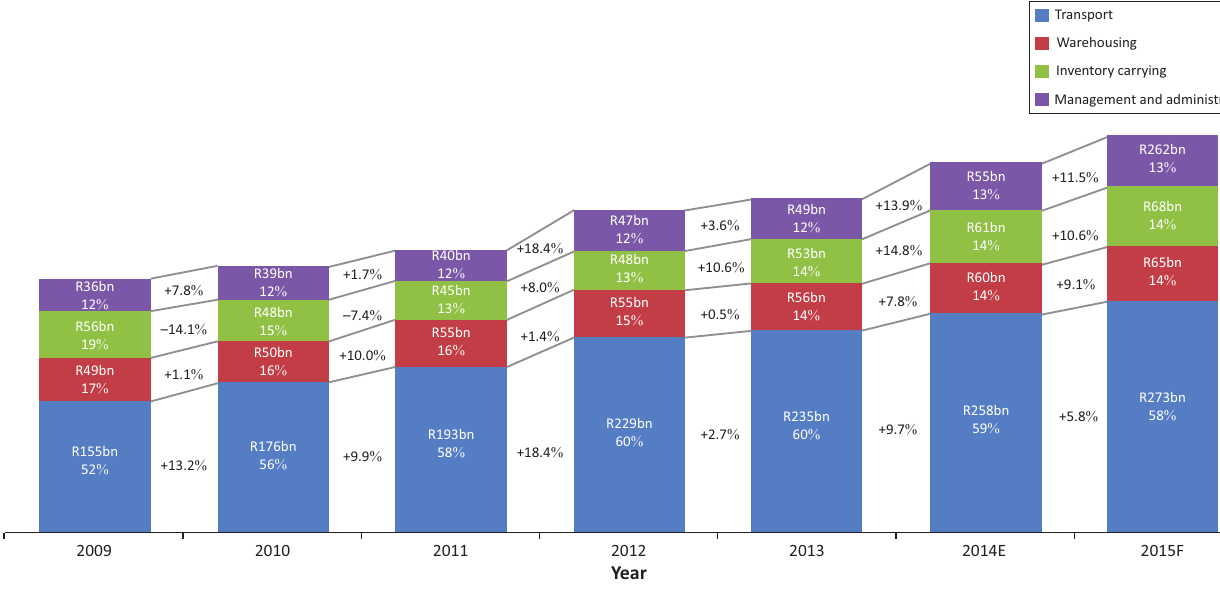
FIGURE 4: Logistics cost components tracked over